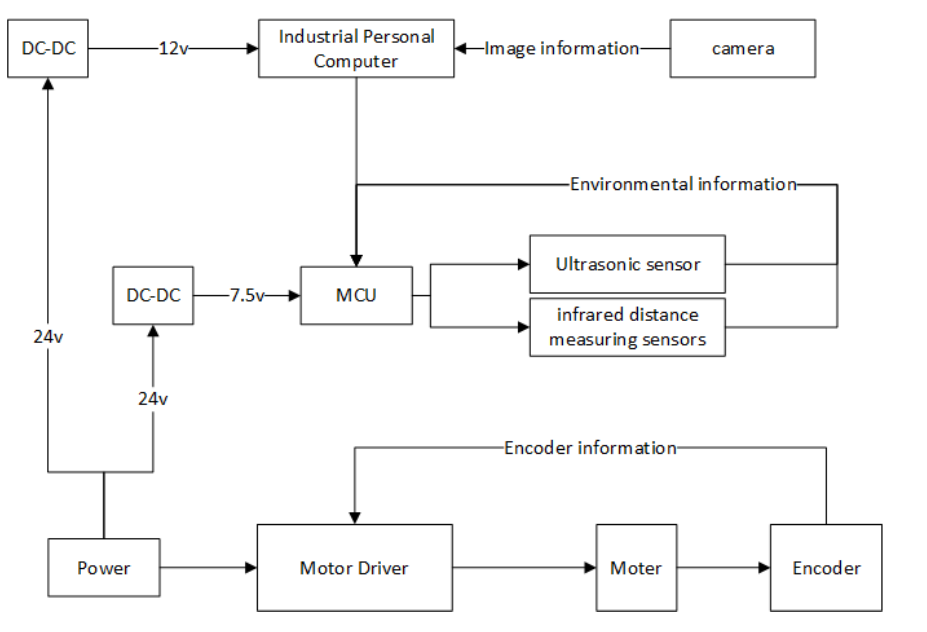
Figure 2. Composition of mobile robot system.